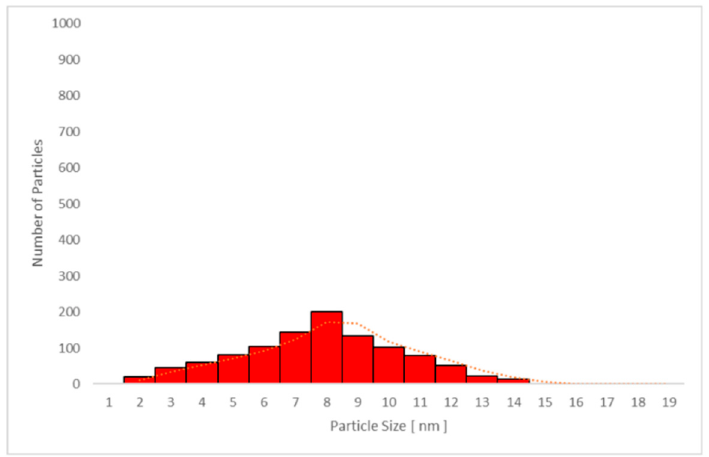
Figure 10. Particle size distribution detected using transmission electron microscopy (TEM) in plasma sample 2 in study C (sunscreen + UV). The average particle size was 6.1 nm (detected only in women due to faster absorption as compared with men).